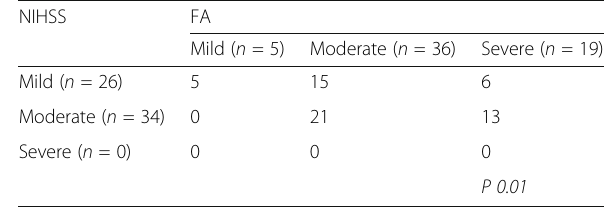
Table 3 Correlation between the degree of FA reduction and NIHSS after 3 months